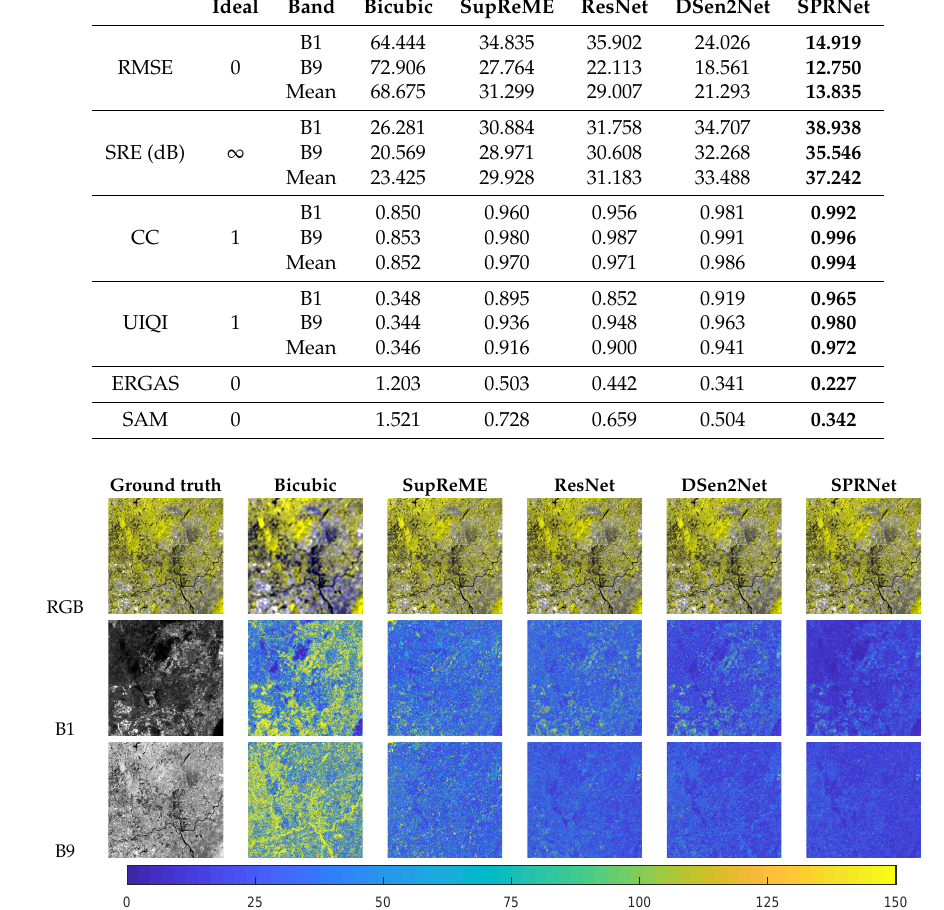
at lower scale (input 360 m, output 60 m) on site 2. ×